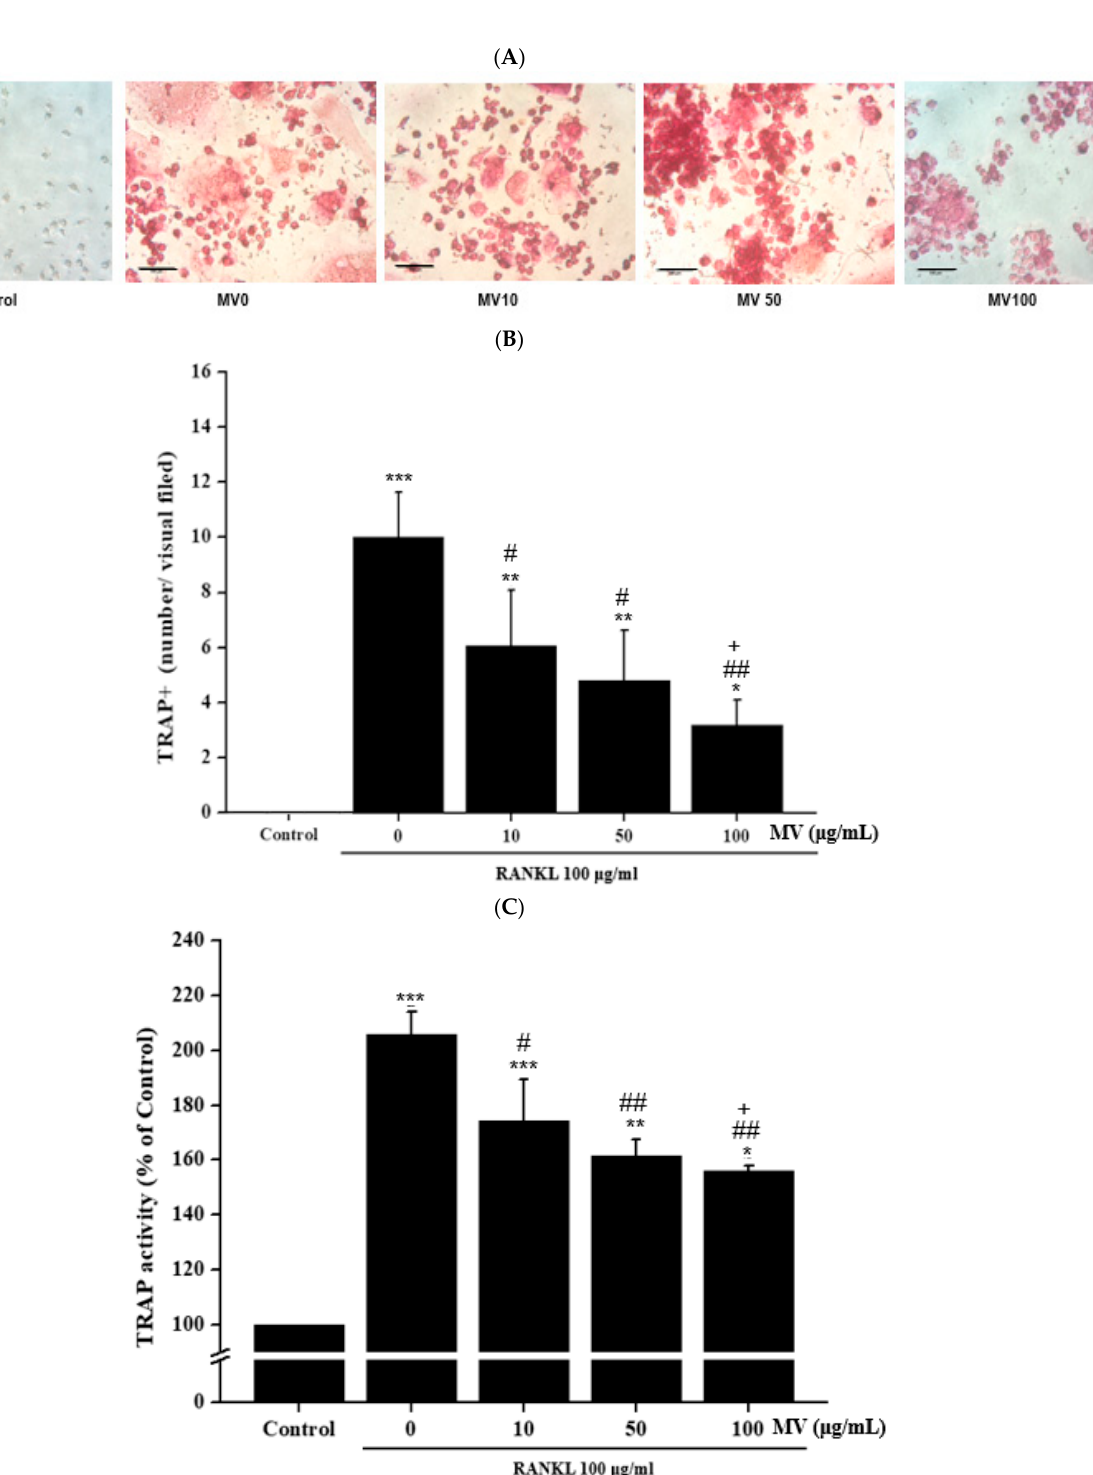
Figure 3. Tartrate-resistant acid phosphatase (TRAP)-positive multinucleated cells (MNC) and TRAP activity in RANKL-induced Raw264.7 cells administered with different dosages of dried mulberry vinegar for five days; ( A ) TRAP staining. The scale bar in the figure indicated 100 µ m and X20 magnification; ( B ) TRAP-positive MNCs; ( C ) TRAP activity; Bars and error bars represented mean ± standard deviation ( n = 5). * Significantly different from the Control at p < 0.05, ** at p < 0.01, and *** at p < 0.001. # Significantly different from the 0 μ g/mL MV treatment at p < 0.05 and ## at p < 0.01. + Significantly different from 10 ng/mL MV treatment at p < 0.05.